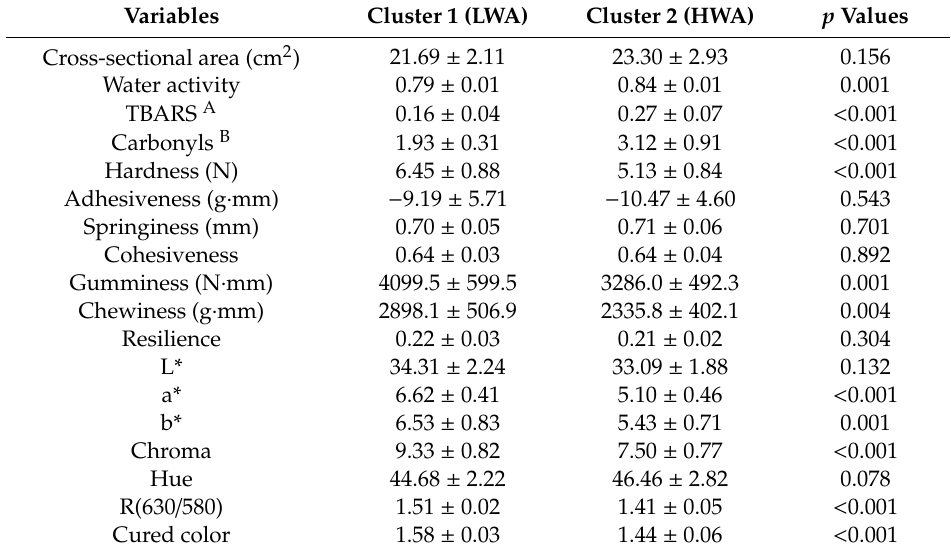
Table 1. Means and standard deviation of physicochemical characteristics obtained from the two clusters formed of Brazilian dry-cured